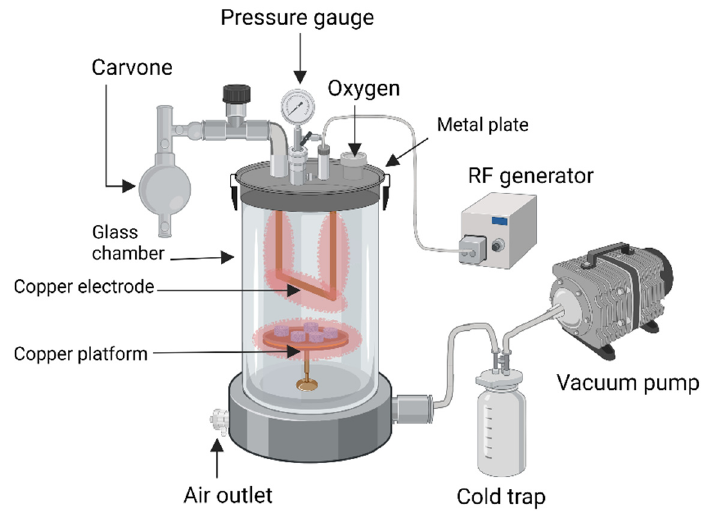
Figure 1. Schematic illustration of the plasma polymerisation mechanism of the collagen scaffolds and the plasma reactor equipment.